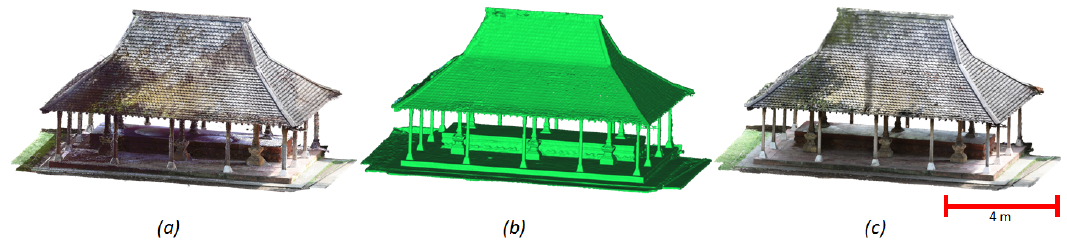
Figure 11. 3D models of the Royal Pavilion; ( a ) the combined point cloud from TLS and photogrammetry, ( b ) 3D meshed model of the combined point cloud, and ( c ) photorealistic textured 3D mesh model. Note the homogenization of textures in ( c